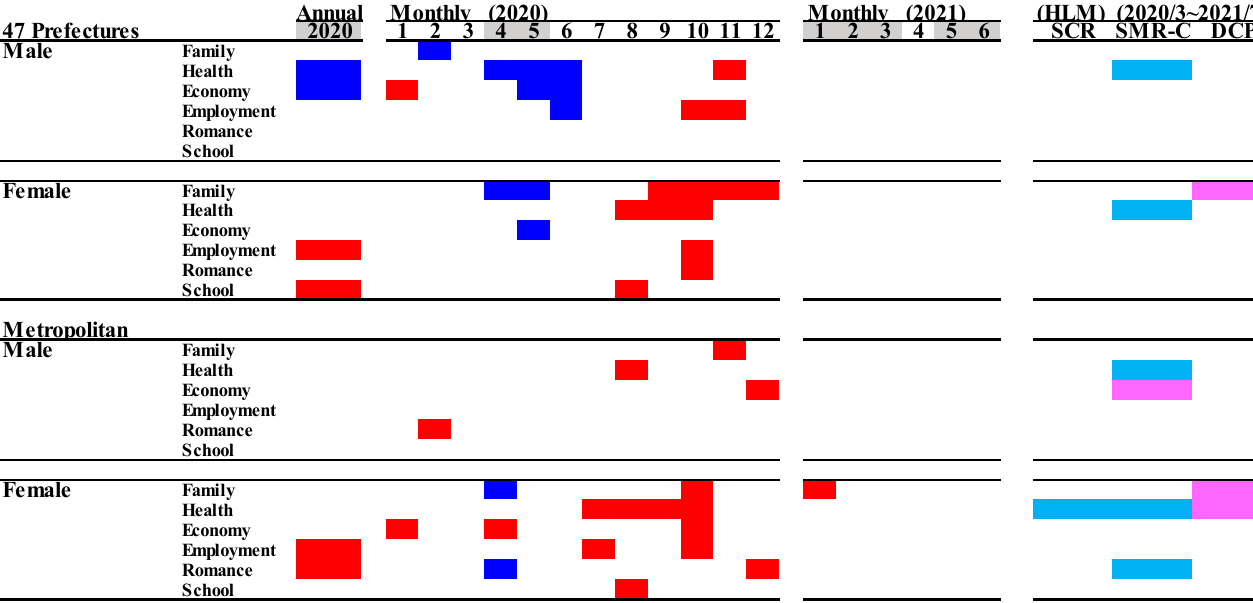
Figure 12. Comparison of annual and monthly SMR-S of males and females caused by suicidal motives during the pan- demic period compared to average SMR-S of the same month during the pre-pandemic period, and impact of COVID-19 pandemic on SMR-S in Japan. Blue and red columns indicate significant decreasing and increasing suicide mortality using a linear mixed-effects model with Tukey’s multiple comparison ( p < 0.05). Light blue and red columns indicate significant decreasing and increasing factors against SMR-S using hierarchical linear model with robust standard error ( p < 0.05). SMR-S: standardised suicide mortality per 100,000 people. SCR: standardised infection with COVID-19 per 100,000 people. SMR-C: standardised mortality caused by COVID-19 per 100,000 people. DCP: during COVID-19 pandemic.